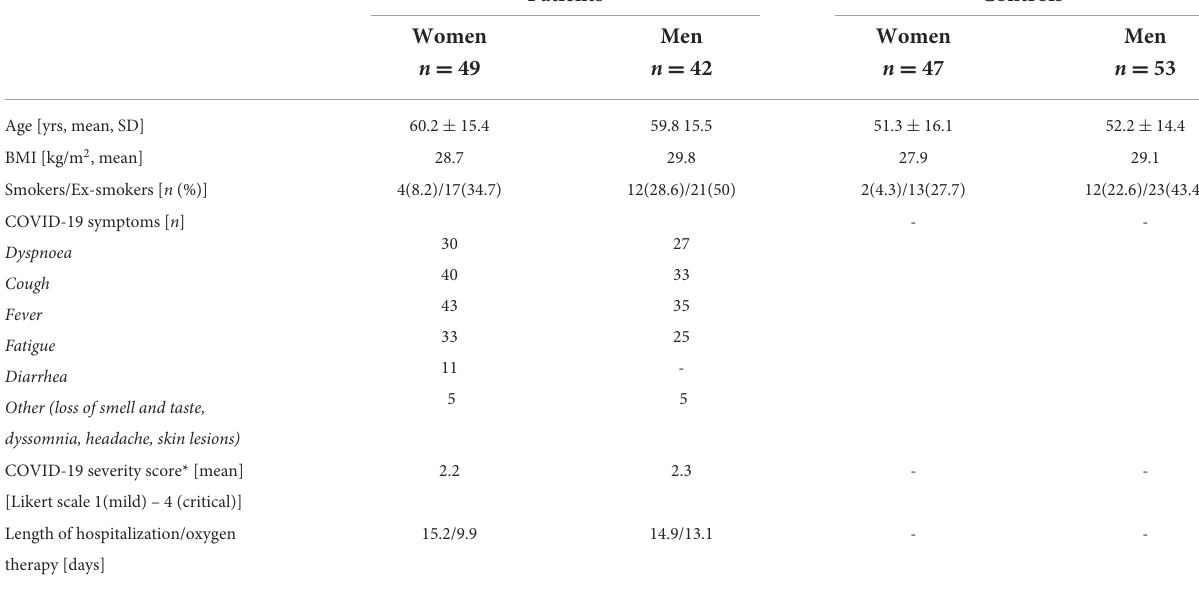
TABLE 4 Demographic and clinical characteristics of patients hospitalized for